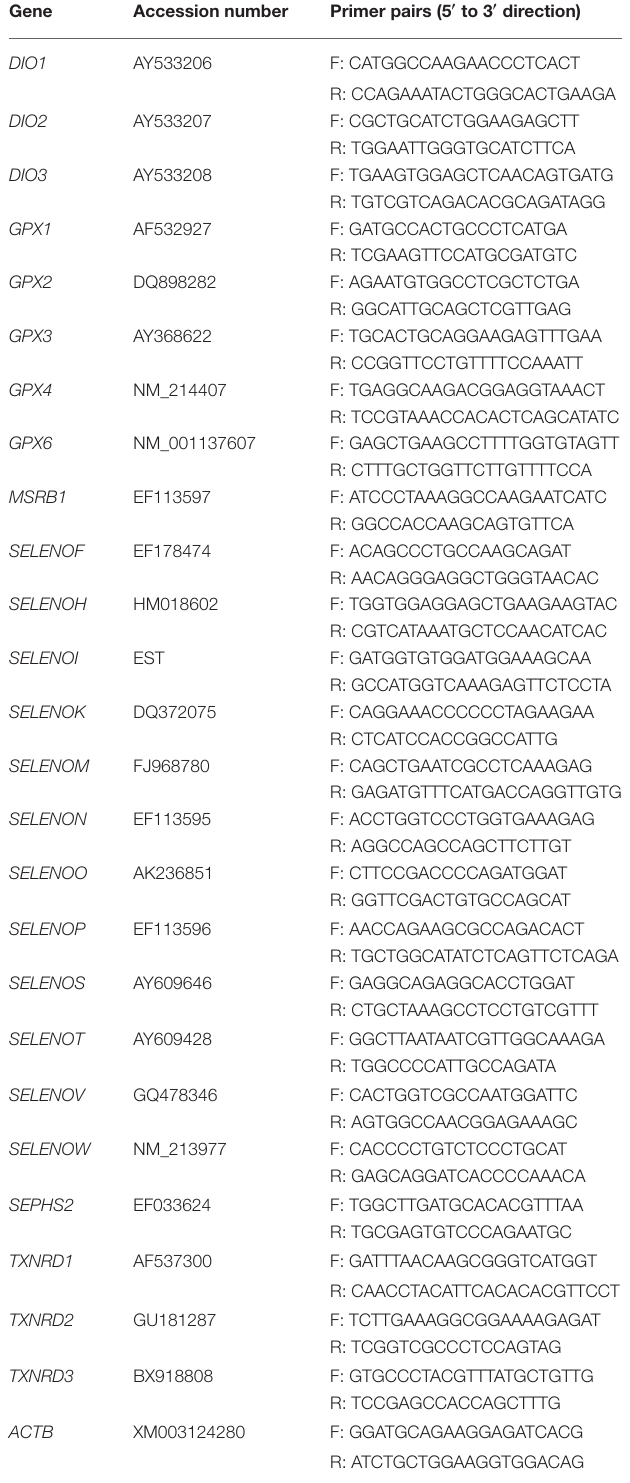
TABLE 1 | Primers used for RT-PCR 1